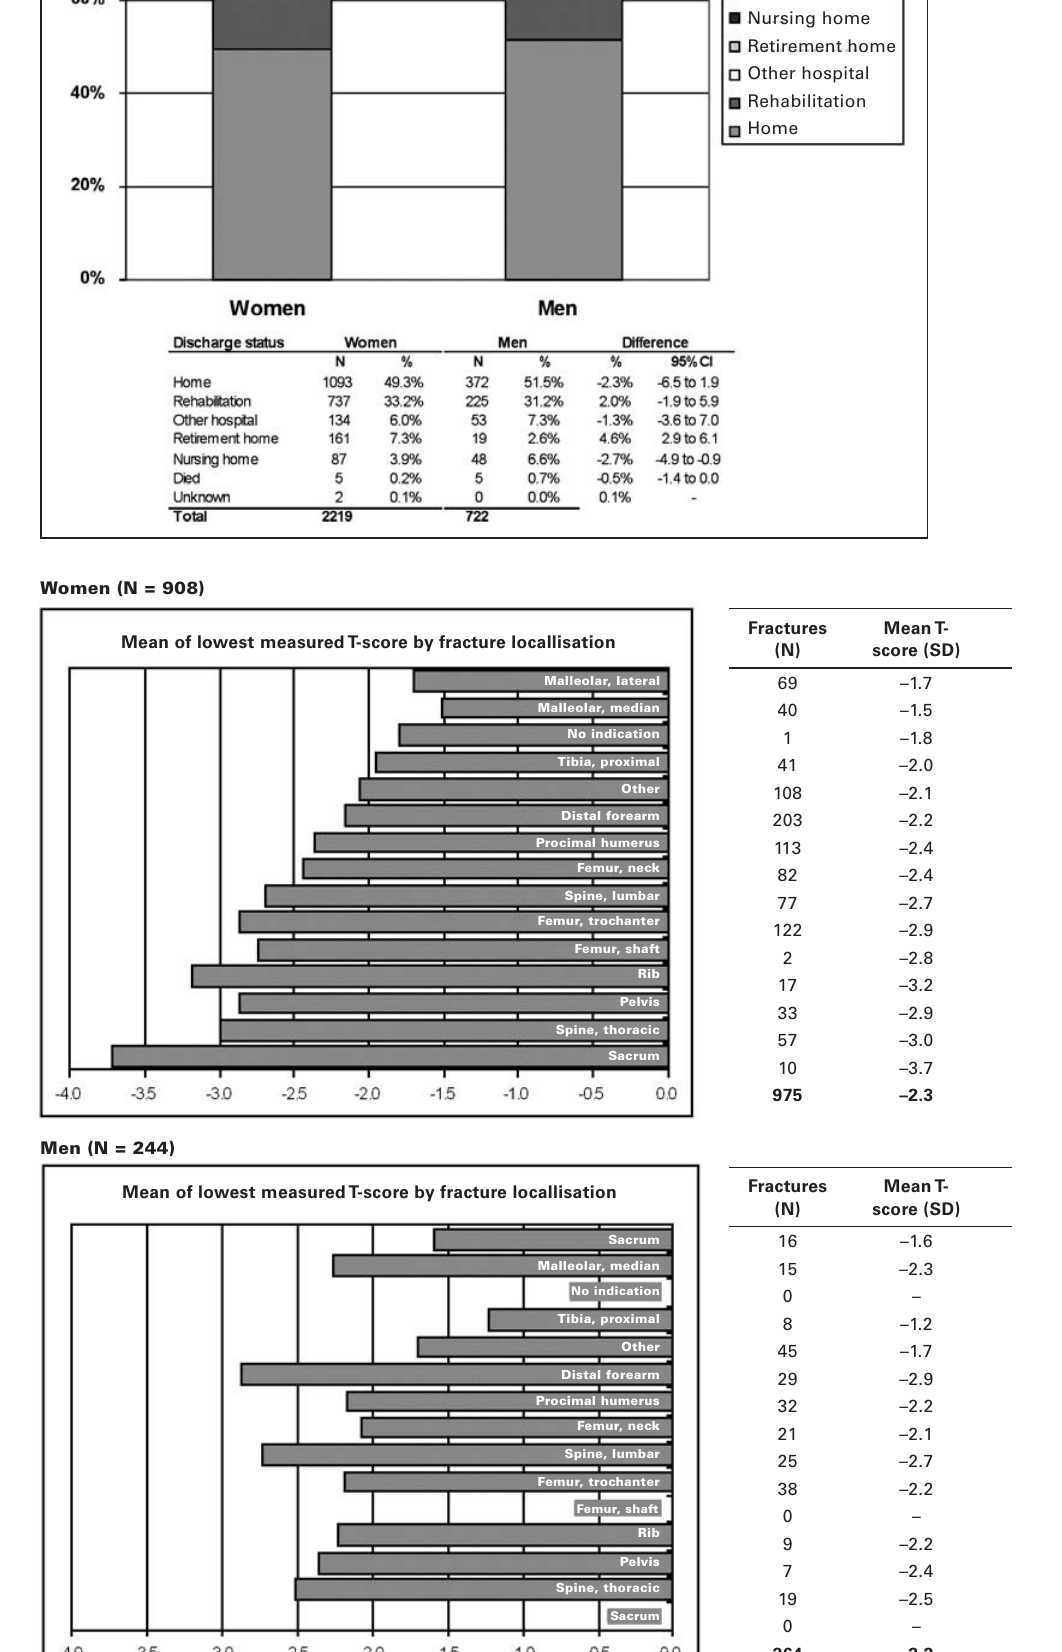
Figure 2 Discharge status of hospitalised patients by gender (n = 2941).